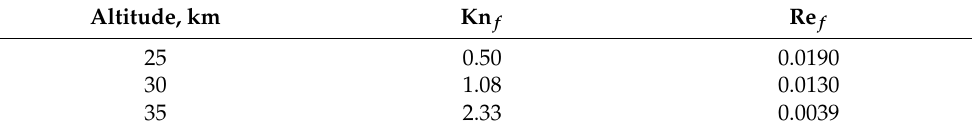
Table 2. Knudsen and Reynolds number values for the domain size simulations seen in Figure 5.